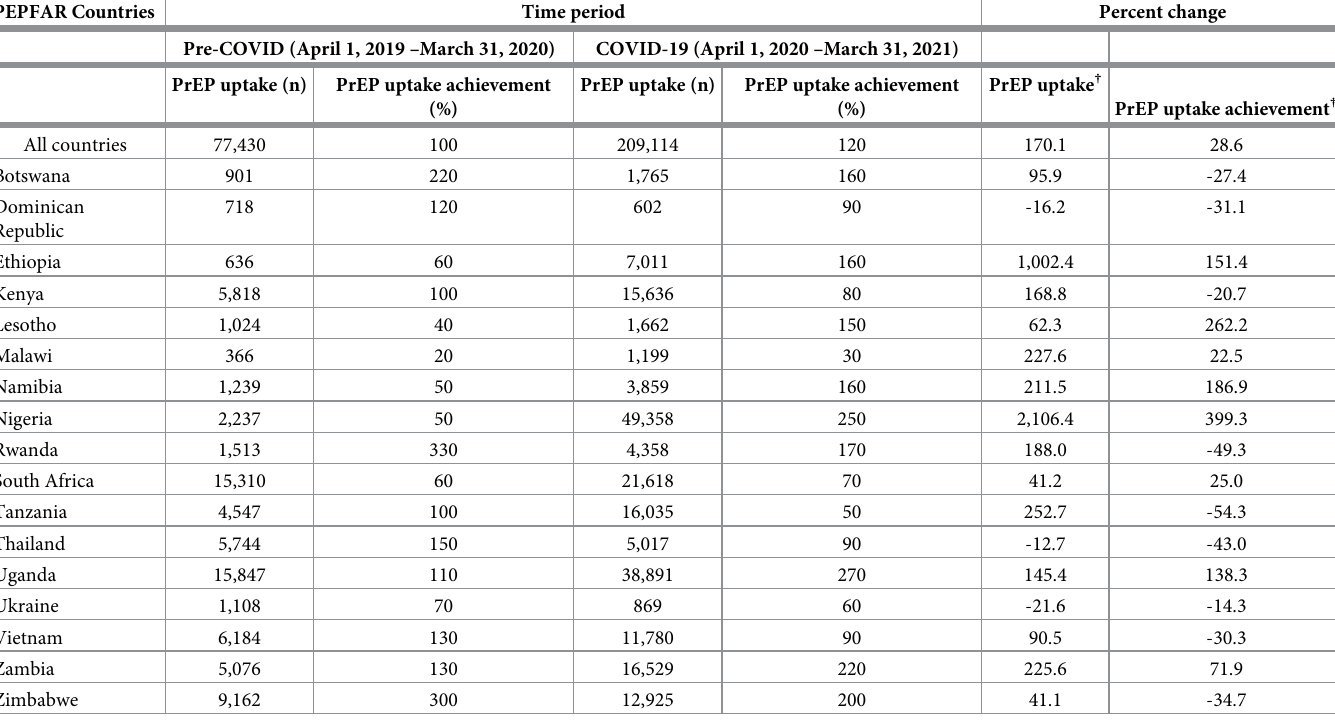
Table 3. New and current preexposure prophylaxis (PrEP) users in PEPFAR-supported countries, by pre-COVID-19 and COVID-19 time periods, among key populations � . PEPFAR